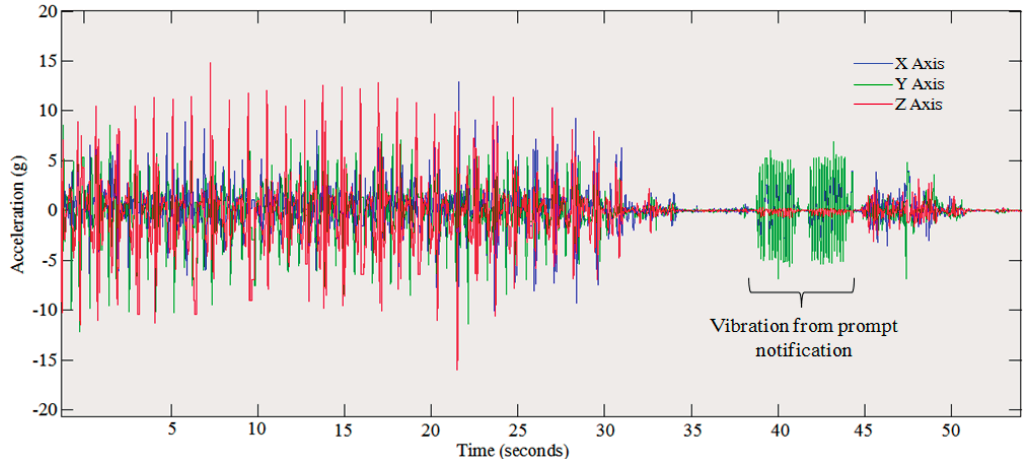
Figure 8. Plot of accelerometry data obtained during experimentation. Two high frequency vibrations can be found in the accelerometer trace. This relates to the vibration alert initiated as part of the prompt